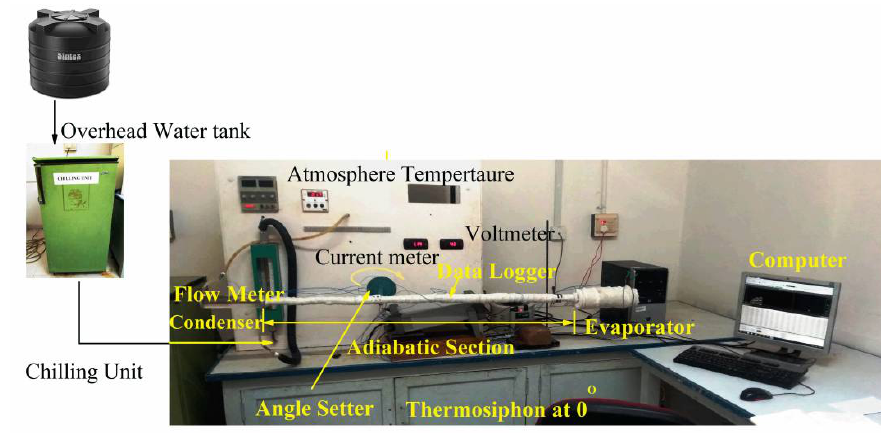
Figure 1. Schematic layout of Experimentation.